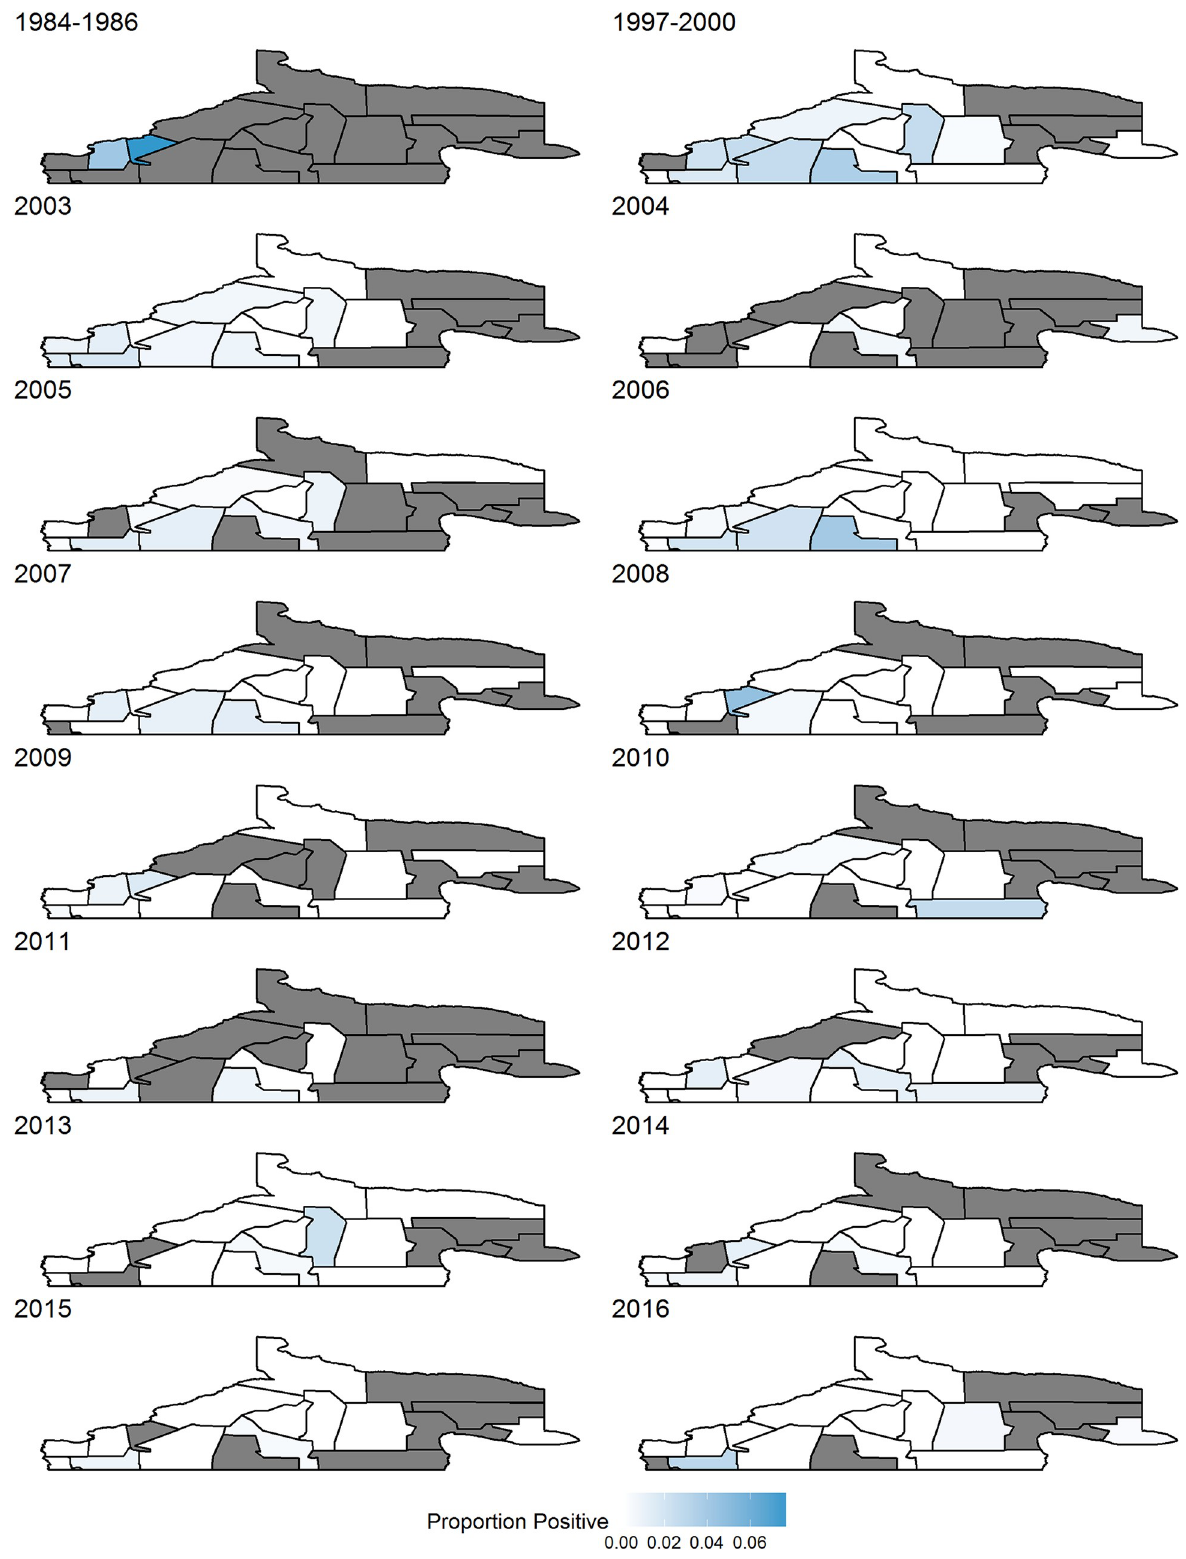
Fig 3. Proportion of screened people who were positive. Grey areas indicate no people were screened in those regions in that time frame.